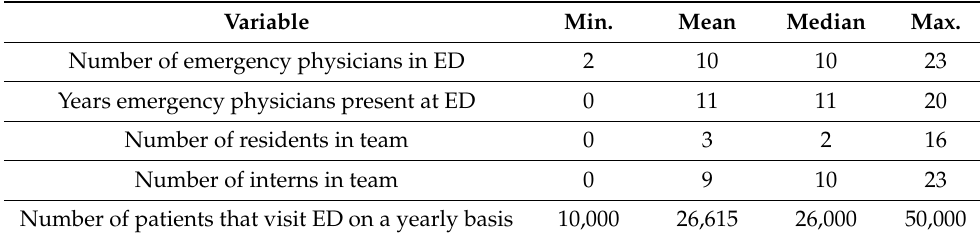
Table 1. Results of characteristics of